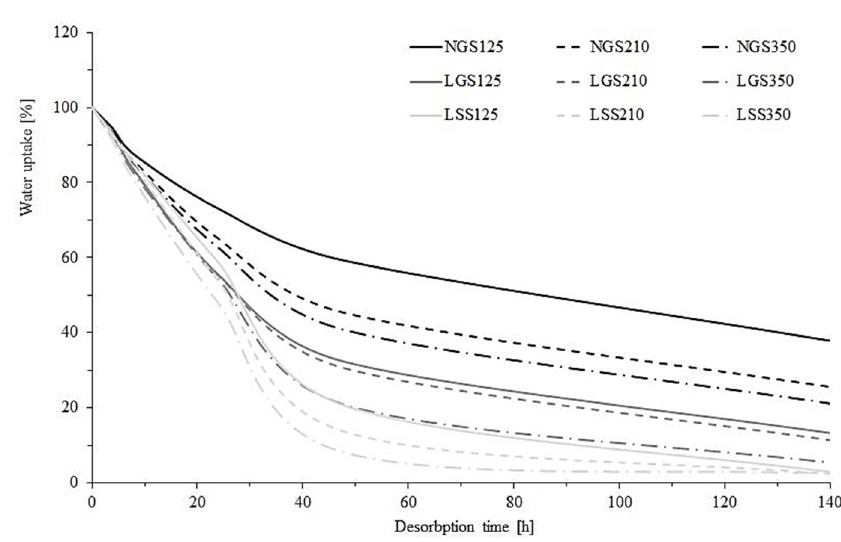
Figure 13. Water desorption curves.